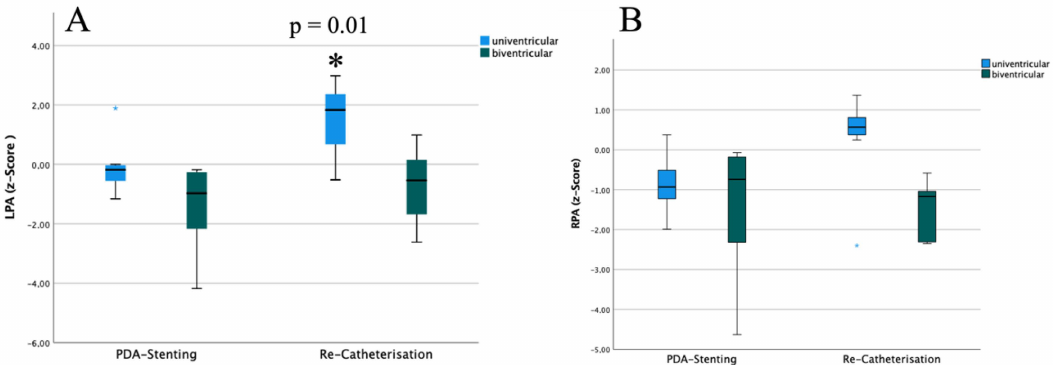
Figure 3. Pulmonary artery growth: Box-and-whiskers plot illustrating pulmonary artery growth; there was better LPA growth in patients undergoing later univentricular palliation compared to those with a biventricular repair. ( A ): Z-Scores for LPA at PDA-stenting and last follow-up ( p = 0.06). Z-score LPA at last follow-up before univentricular palliation was 1.83 (+0.68 to +2.37) vs. those before biventricular repair − 0.54 ( − 1.45 to +0.03) ( p = 0.01). ( B ): Z-score for RPA at PDA-stenting and last follow-up ( p = 0.22). * p = 0.01.